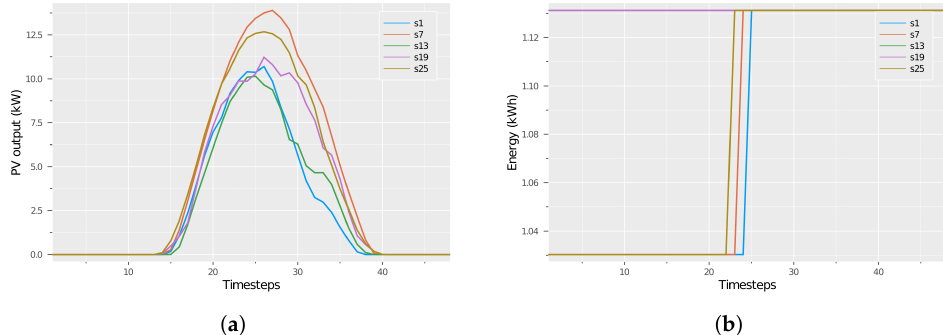
Figure 18. Optimization results for PV and BS using RNN forecast. ( a ) PV output. ( b ) Energy stored in BS.